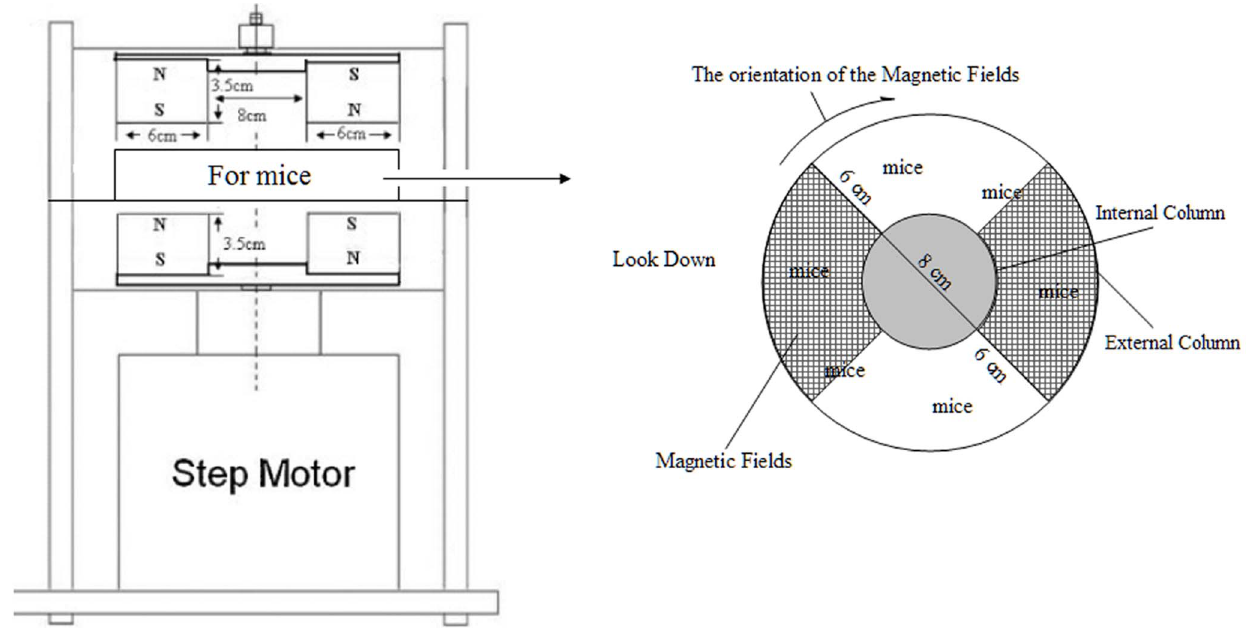
Figure 7. Magnetic fields regulate Th17/Treg balance and down-regulate the inhibitory function of Treg cells in spleen. (A) Flow cytometry analysis of Th1, Th2, Th17 and Treg cell populations in spleen. (B) Summarized data of Th1, Th2, Th17 and Treg cell populations in spleen. (C) mRNA expression of T-bet, GATA3, ROR c and Foxp3 in splenic lymphocytes were detected by qPCR. (D) Inhibitory function of Treg cells in each group were detected by mixed lymphocyte reaction. (E) The mean mass of spleen for each group (Mean 6 s.e.m.). * P , 0.05, ** P , 0.01, *** P , 0.001, or ns=No significant difference.